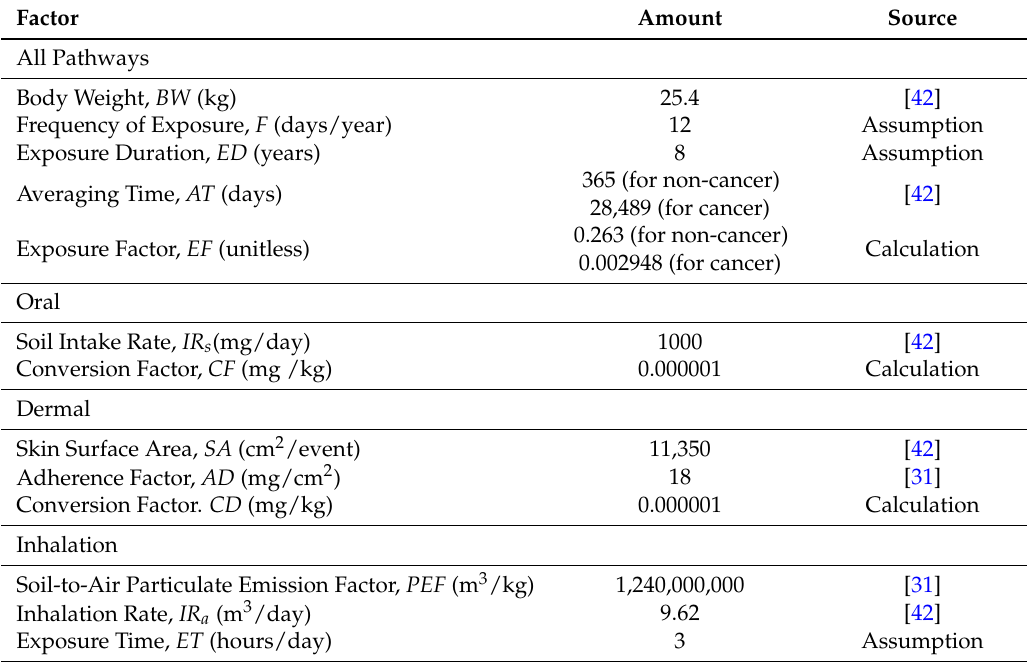
Table 3. Factors utilized for exposure assessment that are independent of chemicals